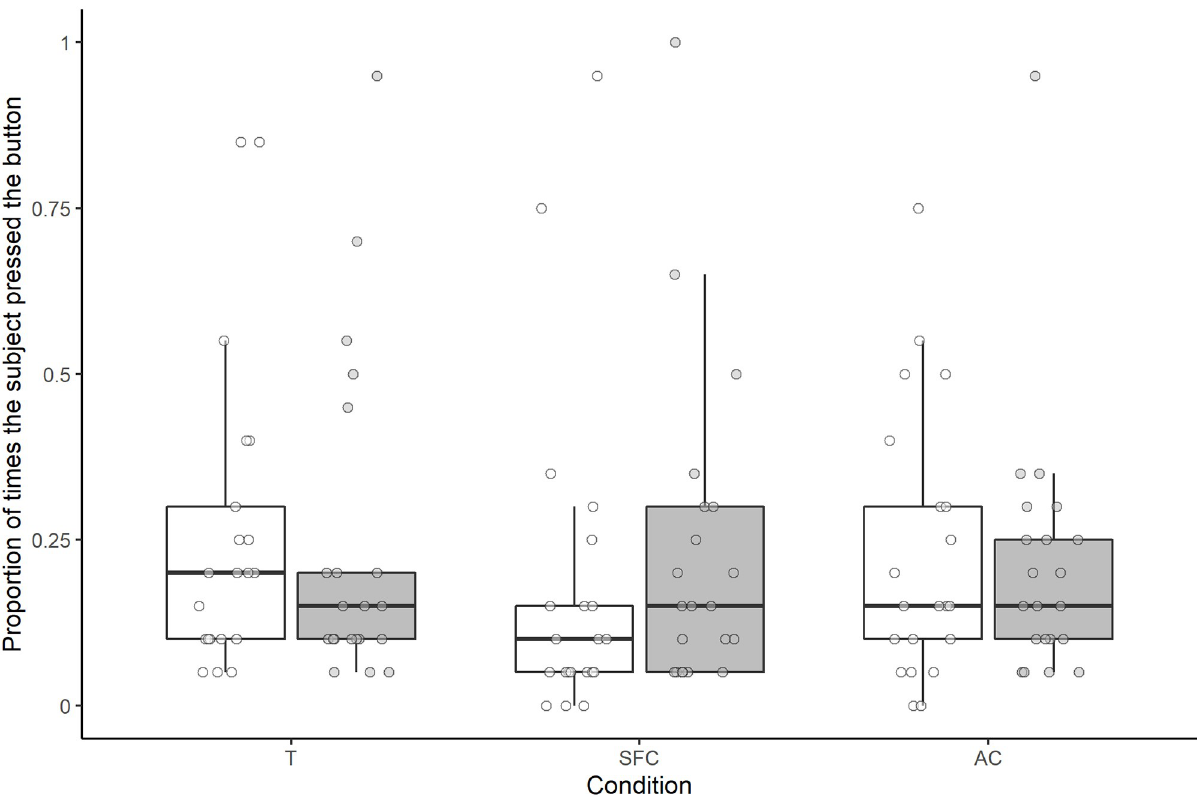
Fig 9. Proportion of times the subjects pressed the button in each condition for each human type. Pressing for the helpful human is represented in white and pressing for the unhelpful human is represented in grey. Boxes display the interquartile range, black horizontal bars represent the median, whiskers represent the range of data points within 1.5 times the interquartile range from the upper and lower hinge, and circles represent individual data points. T, test; SFC, social facilitation control; AC, asocial control.